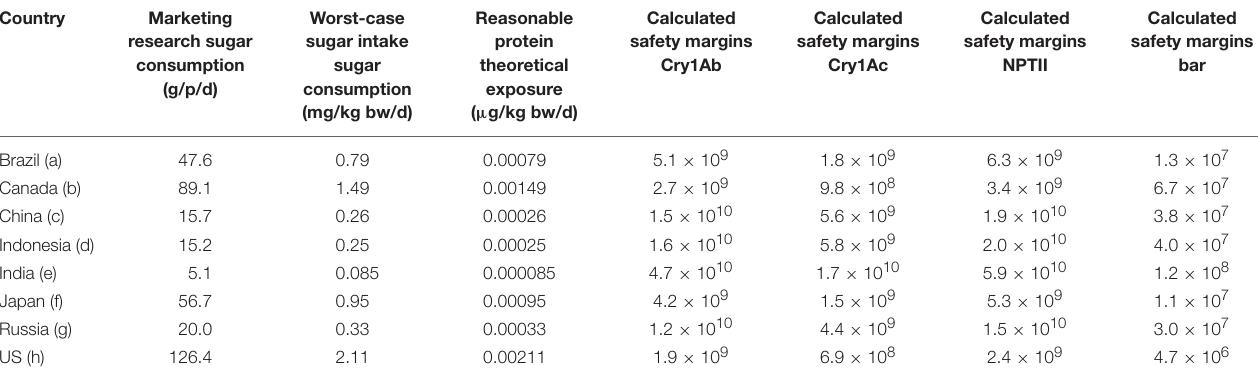
TABLE 5 | Safety margins at “Reasonable-case” protein exposure in eight countries. Country Marketing research